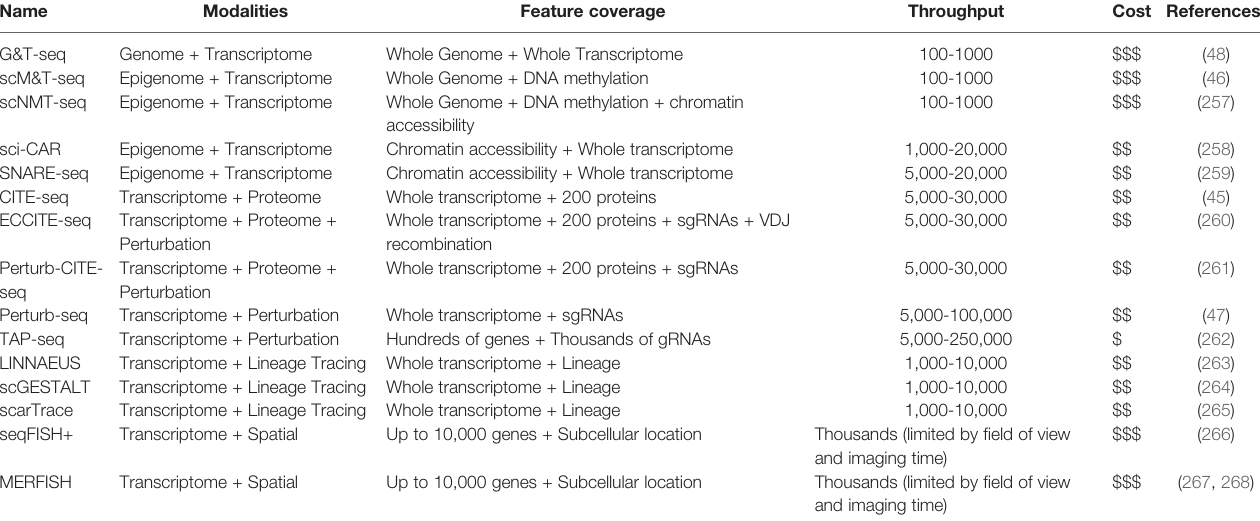
TABLE 2 | Multimodal single-cell